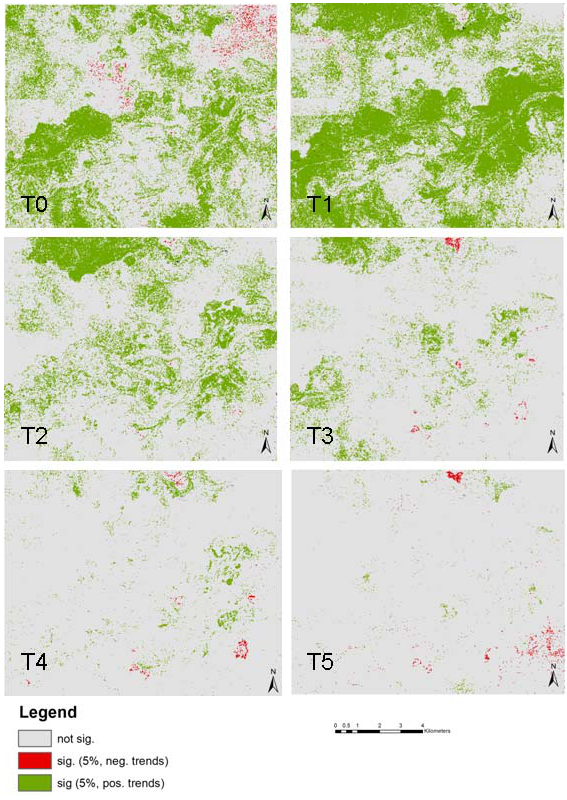
Figure 5: NDVI vs Rainfall anomalies significance (t-test) at the 5% significance level of the regression coefficients at times T0 to